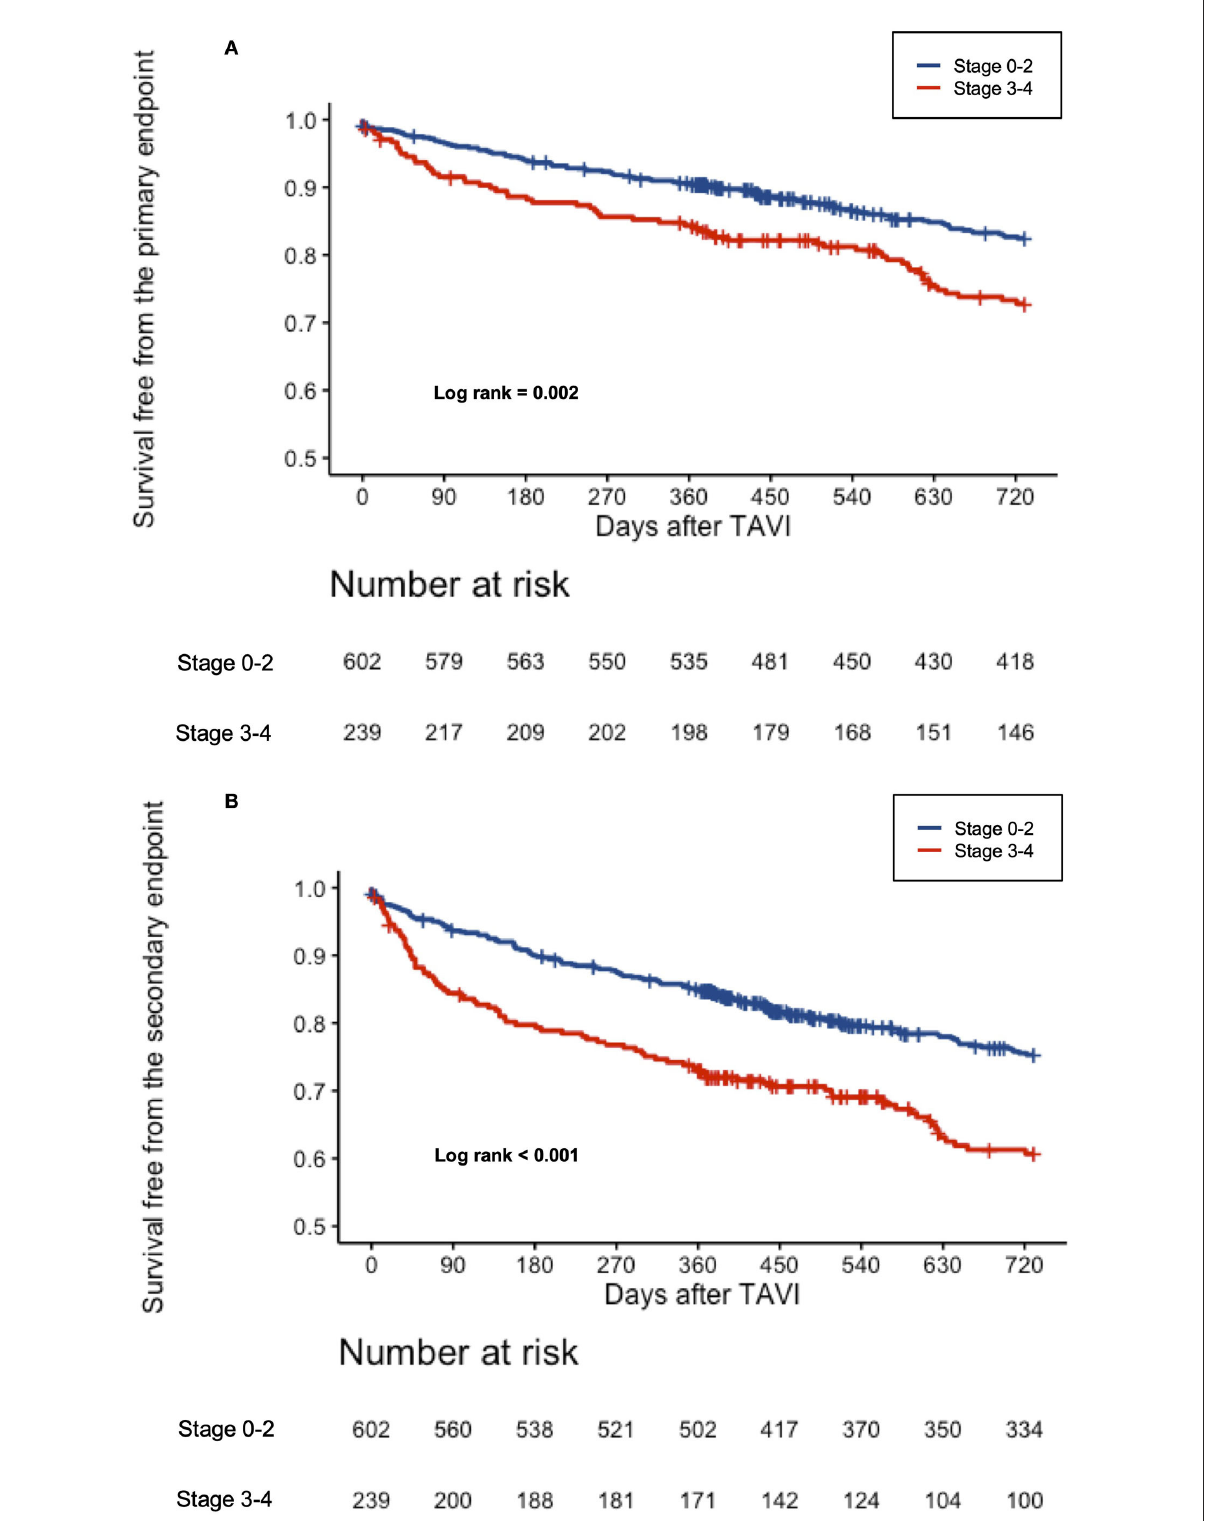
FIGURE2 (A) Cumulative incidence of all-cause mortality according to the dichotomized stages of cardiac damage. Kaplan–Meier curves showing cumulative incidence of all-cause mortality according to the dichotomized stages of cardiac damage. (B) Cumulative incidence of the composite all-cause mortality or rehospitalization for worsening CHF according to the dichotomized stages of cardiac damage. Kaplan–Meier curves showing cumulative incidence of the composite all-cause mortality according to the dichotomized stages of cardiac